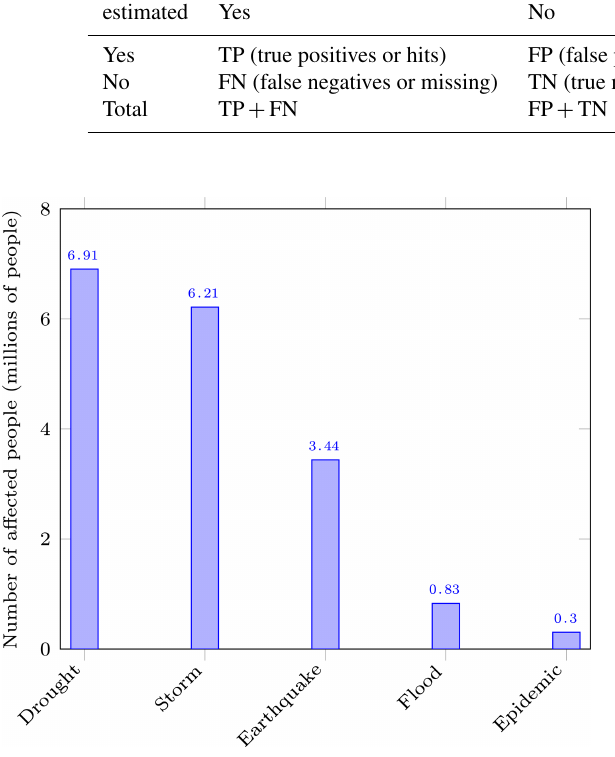
Figure 3. Number of people affected by natural disasters in Haiti (1900–2018). Source: CRED